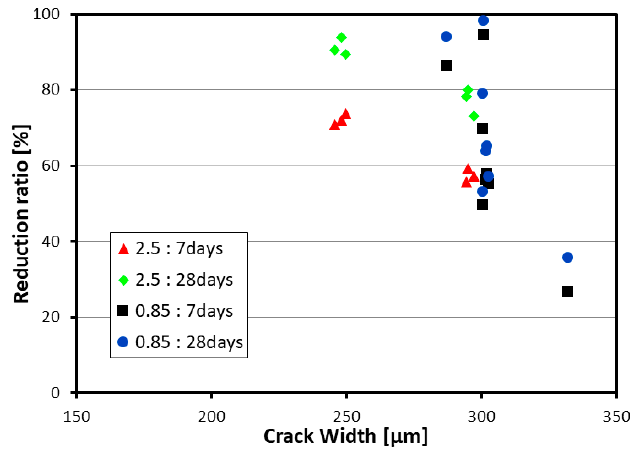
Figure 8. Water flow test results.